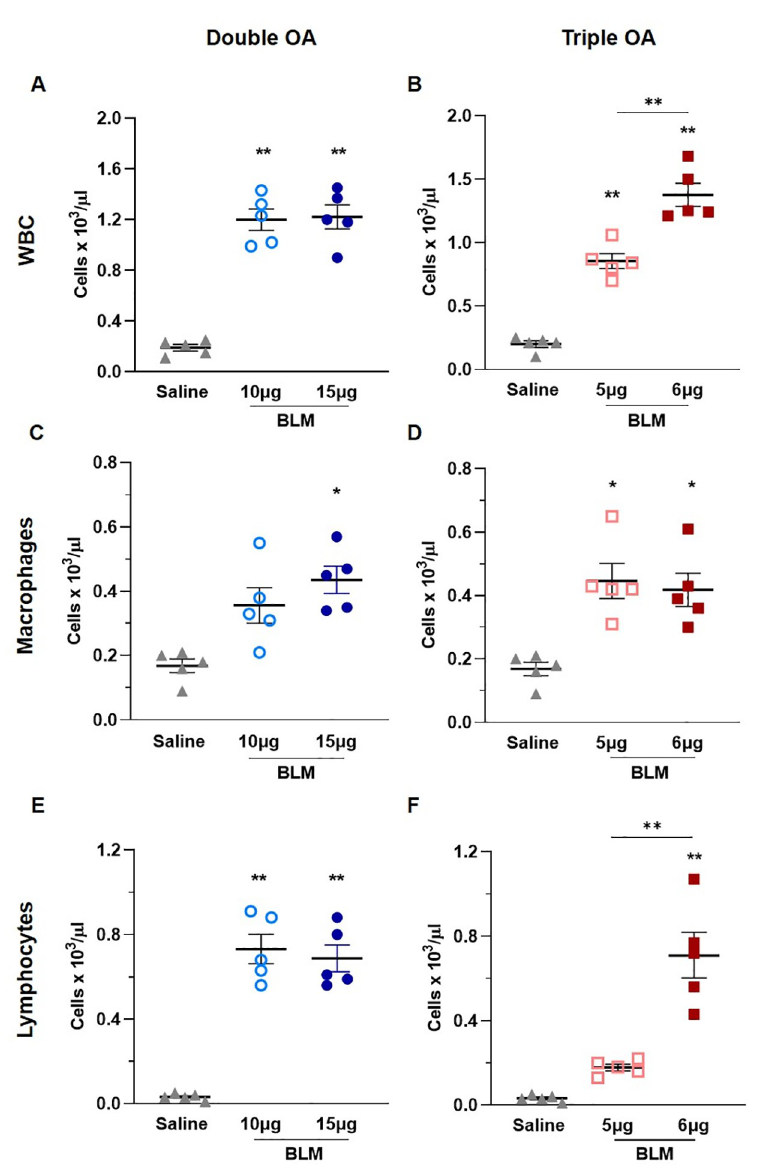
Fig 5. Inflammatory cells infiltration in BALF. Levels of total white blood cells (A, B), macrophages (C, D) and lymphocytes (E, F) in BALF of animals receiving saline, double and triple doses of BLM. Data are shown as mean ± SEM. Statistical significance was calculated between the animal groups by one-way ANOVA followed by Tukey’s test ( � p < 0.05; �� p < 0.01). N = 5 per group.